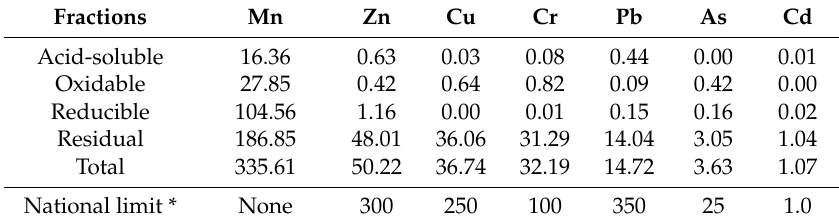
Table 2. The fractions and total amounts of heavy metals in the tested urban soil (mg kg − 1